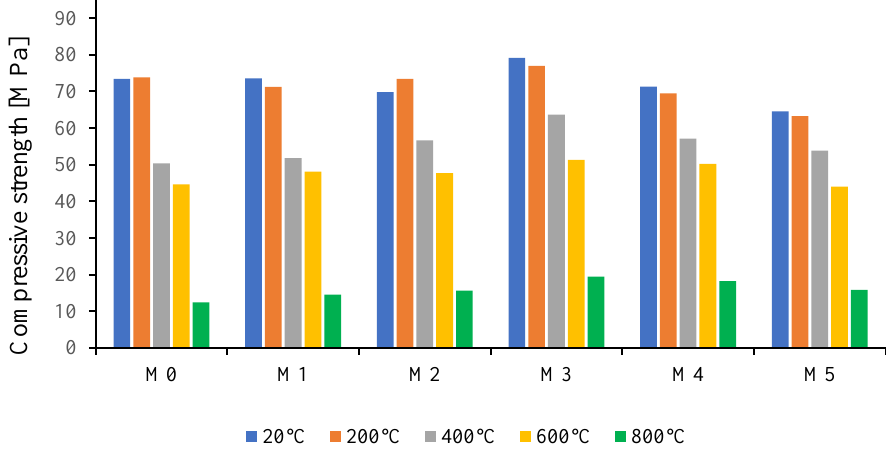
Figure 2. Compressive strength of the heated mortars.